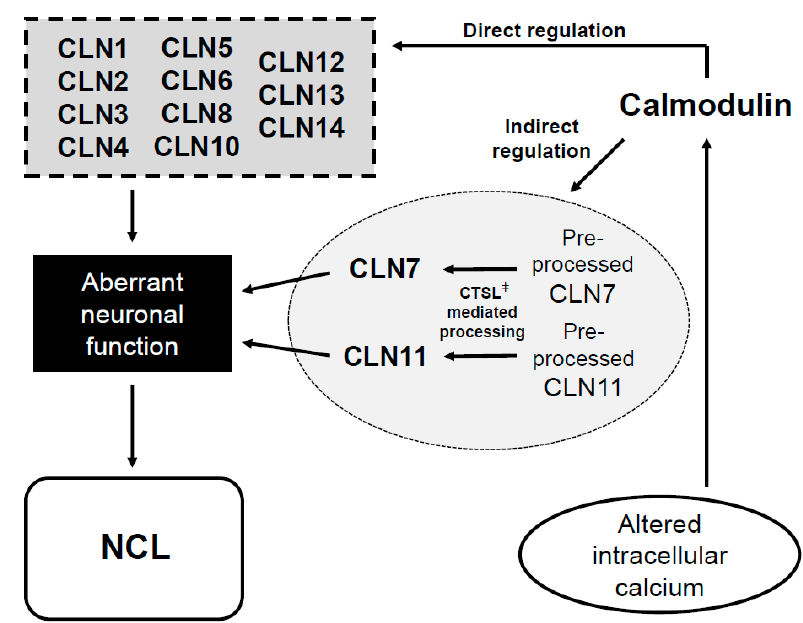
Figure 2. Proposed model linking calmodulin to neuronal ceroid lipofuscinosis. Altered levels of intracellular calcium underlie neuronal ceroid lipofuscinosis (NCL). Since calmodulin (CaM) is the primary downstream target of calcium, in turn, its binding proteins (i.e., CaMBPs) will be involved in facets of the disease. Eleven proteins linked to NCL contain putative CaM-binding domains (CaMBDs) (CLN1–6, CLN8, CLN10, and CLN12–14), suggesting a direct interaction with CaM. Cathepsin L (CTSL), an enzyme that processes CLN7 and CLN11, also contains a CaMBD. Thus, CaM is capable of directly regulating the NCL proteins or indirectly regulating them through CTSL. Mutations in NCL proteins affect neuronal function and results in neurodegeneration. Arrows indicate the links between calcium, CaM, the NCL proteins, and NCL. ‡ Non-NCL protein.